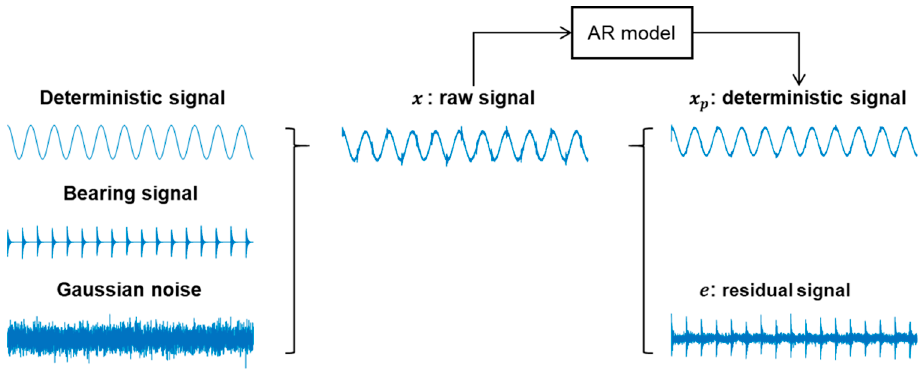
Figure 6. Flow chart on how the residual signals are obtained.